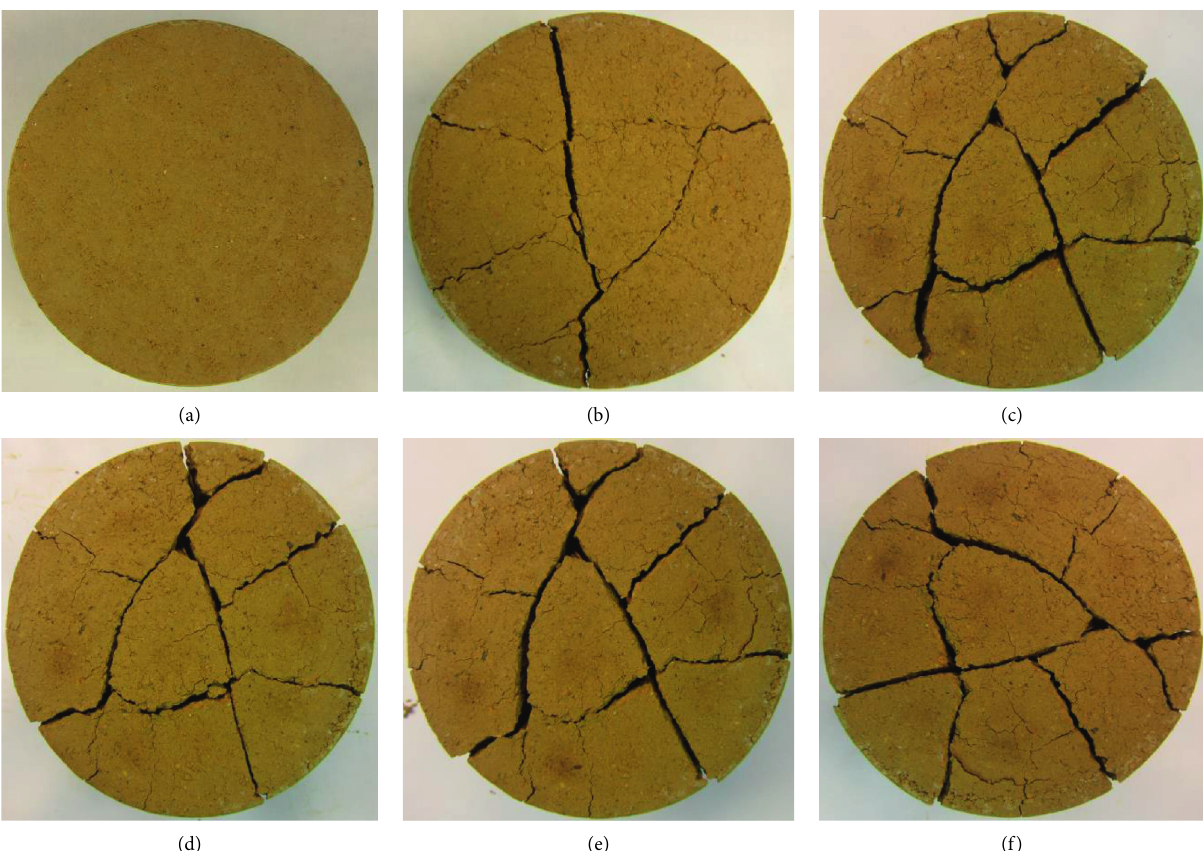
Figure 5: Images of crack development process. (a) Zeroth cycle. (b) First cycle. (c) Second cycle. (d) Third cycle. (e) Fourth cycle. (f) Fifth cycle.